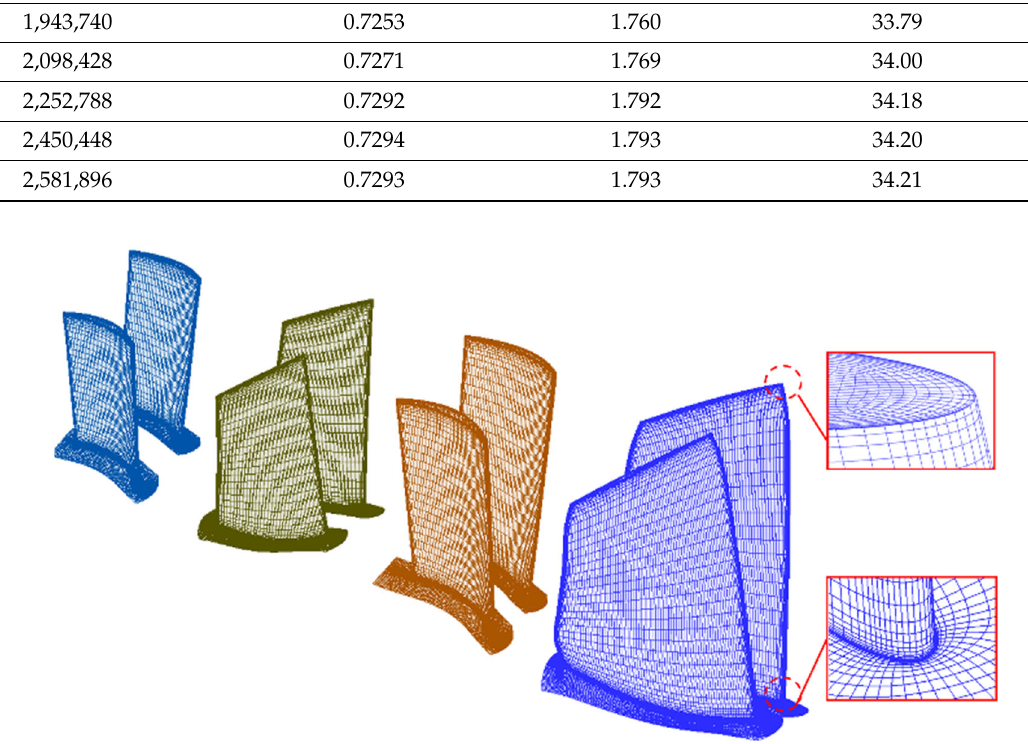
Figure 3. The geometry and grid structure of the two-stage fan.